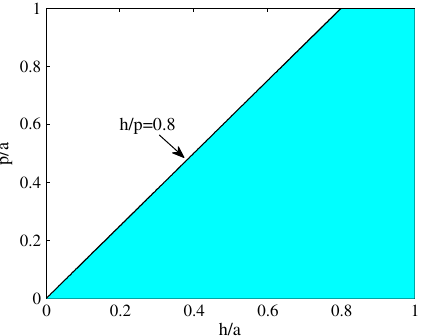
FIG. 17. Quality factor by field matching algorithm (blue dots) and corresponding best fit to Eq. (A7) (red dashed